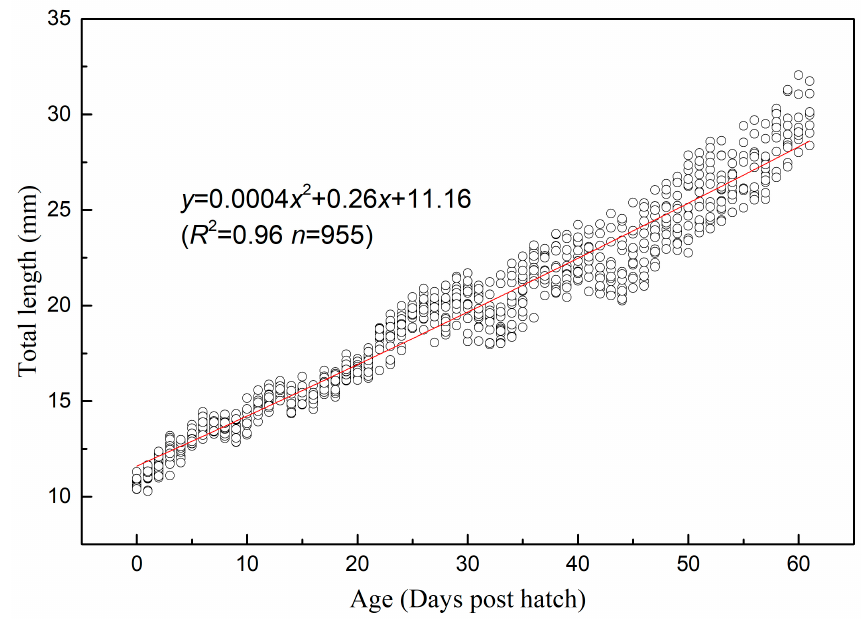
Figure 2. The correlation relationship between days post-hatch and total length of S. waltoni Regan during larval and juvenile periods.